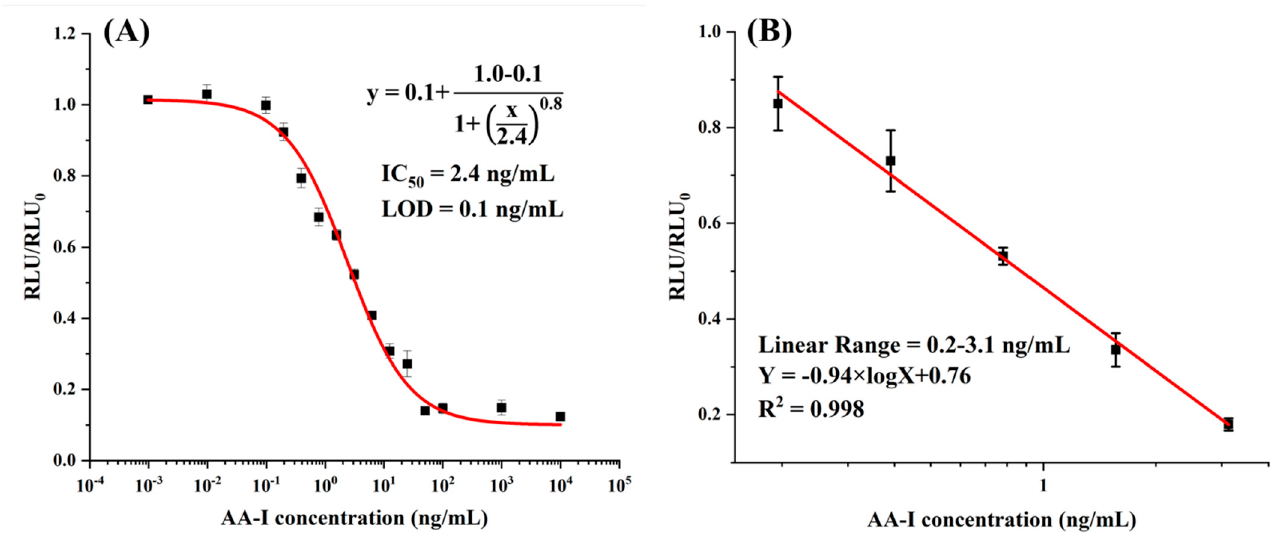
Figure 2. ( A ) The calibration curve; ( B ) the linear range of CLEIA. Table 2. The specific test of anti ‐ AA ‐ I mAb.